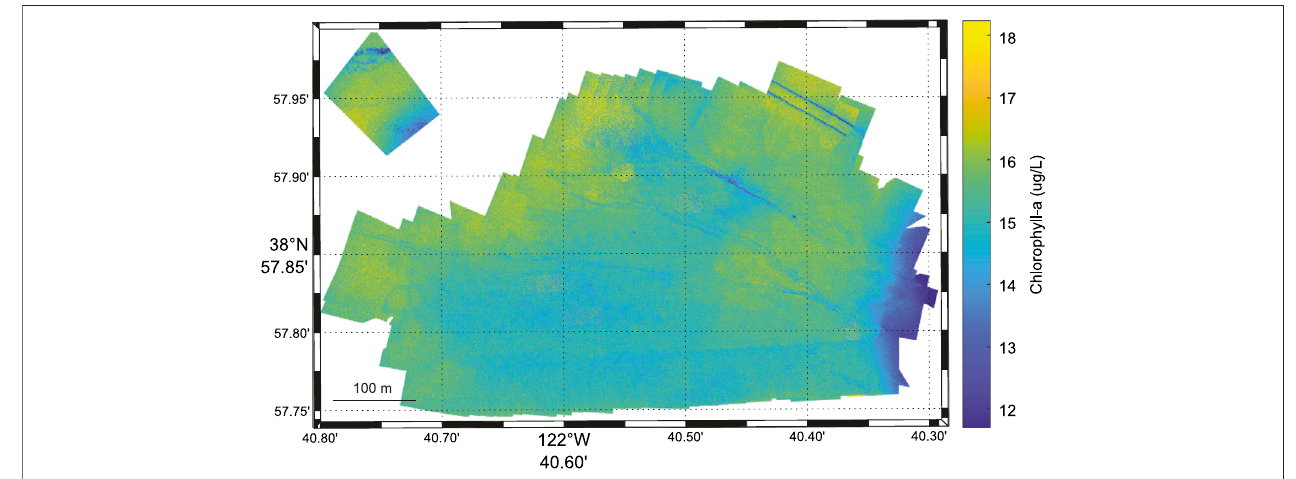
FIGURE 6 | sUAS-derived chlorophyll- a ( μ g/L) image from August 16, 2019. Spatial variability is observed in the sUAS-derived chlorophyll- a image with higher concentrations observed near the northern portions and through an area in the eastern portion of the